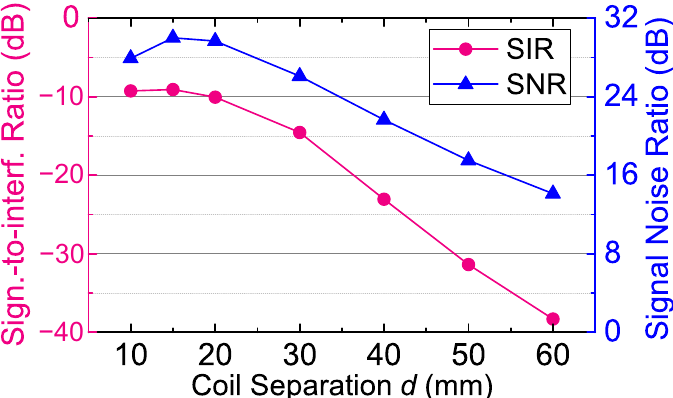
Figure 13. The measured signal-to-interference ratio (SIR) and the SNR of the uplink versus the coil separation d